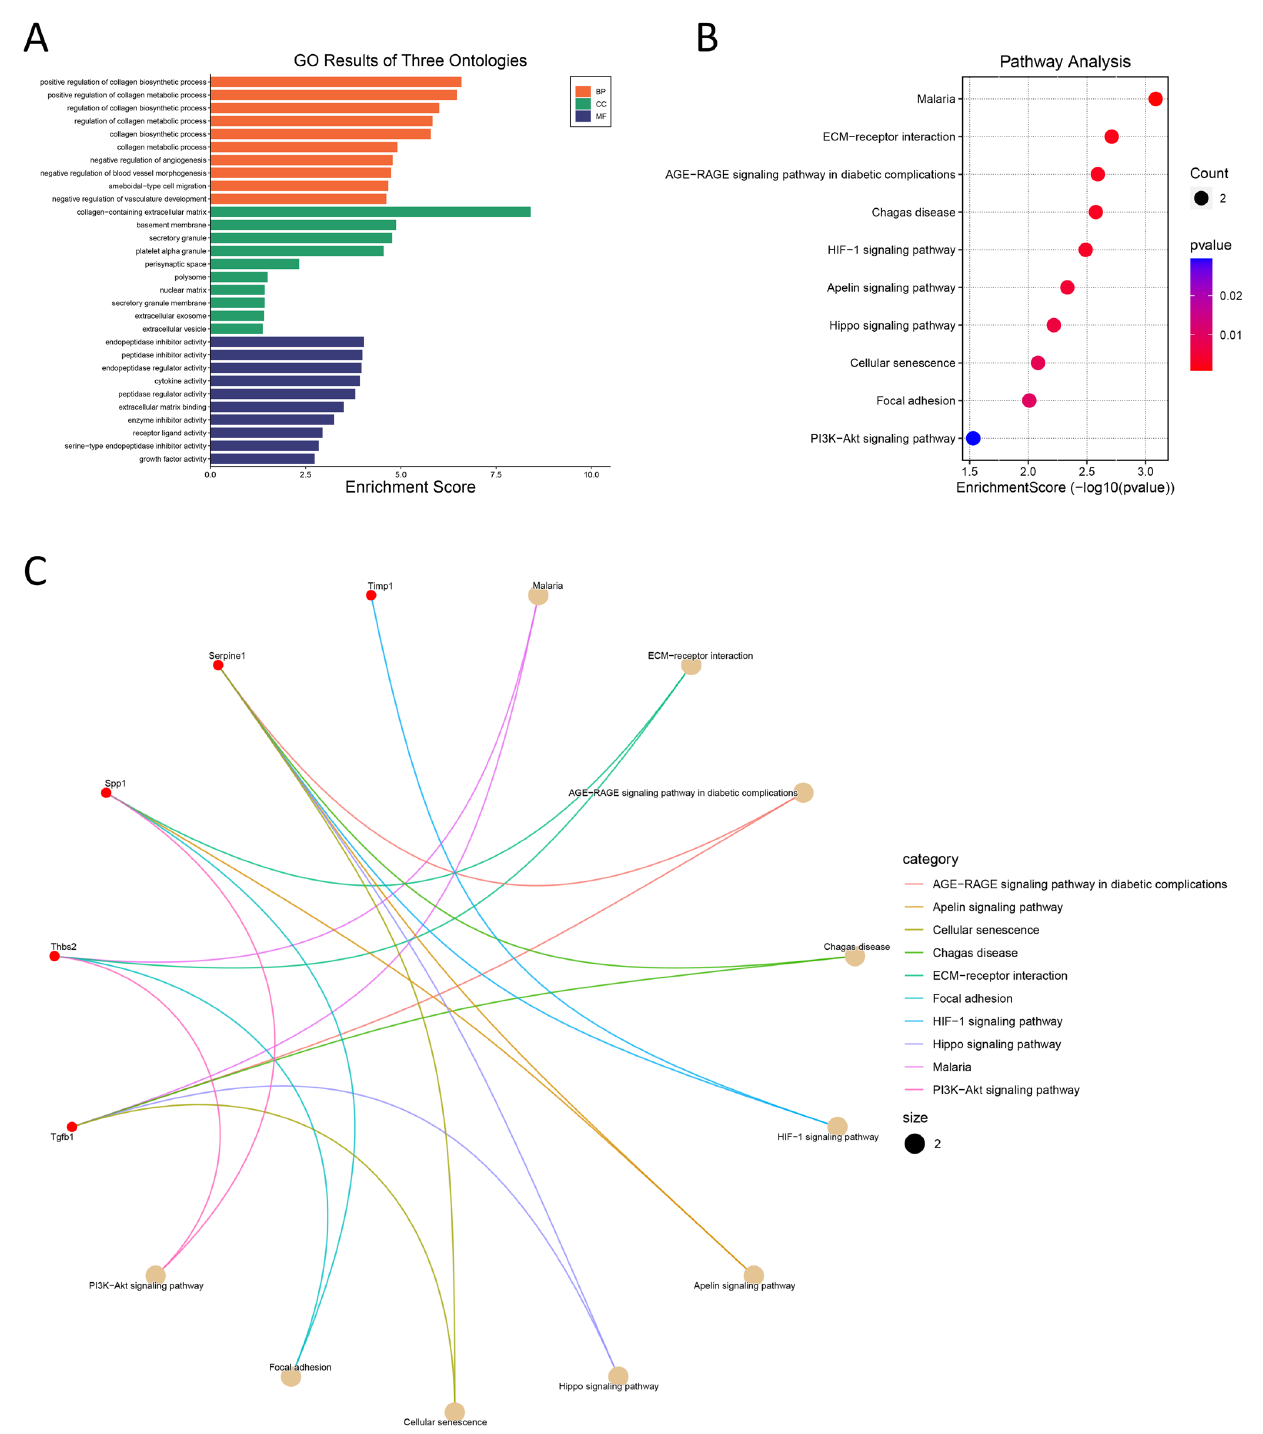
Figure 4. GO and KEGG enrichment analyses. ( A ) Histogram of the top 10 GO enrichment terms for each GO category. ( B ) Bubble of enriched KEGG pathways. ( C ) Relationship between hub genes and KEGG